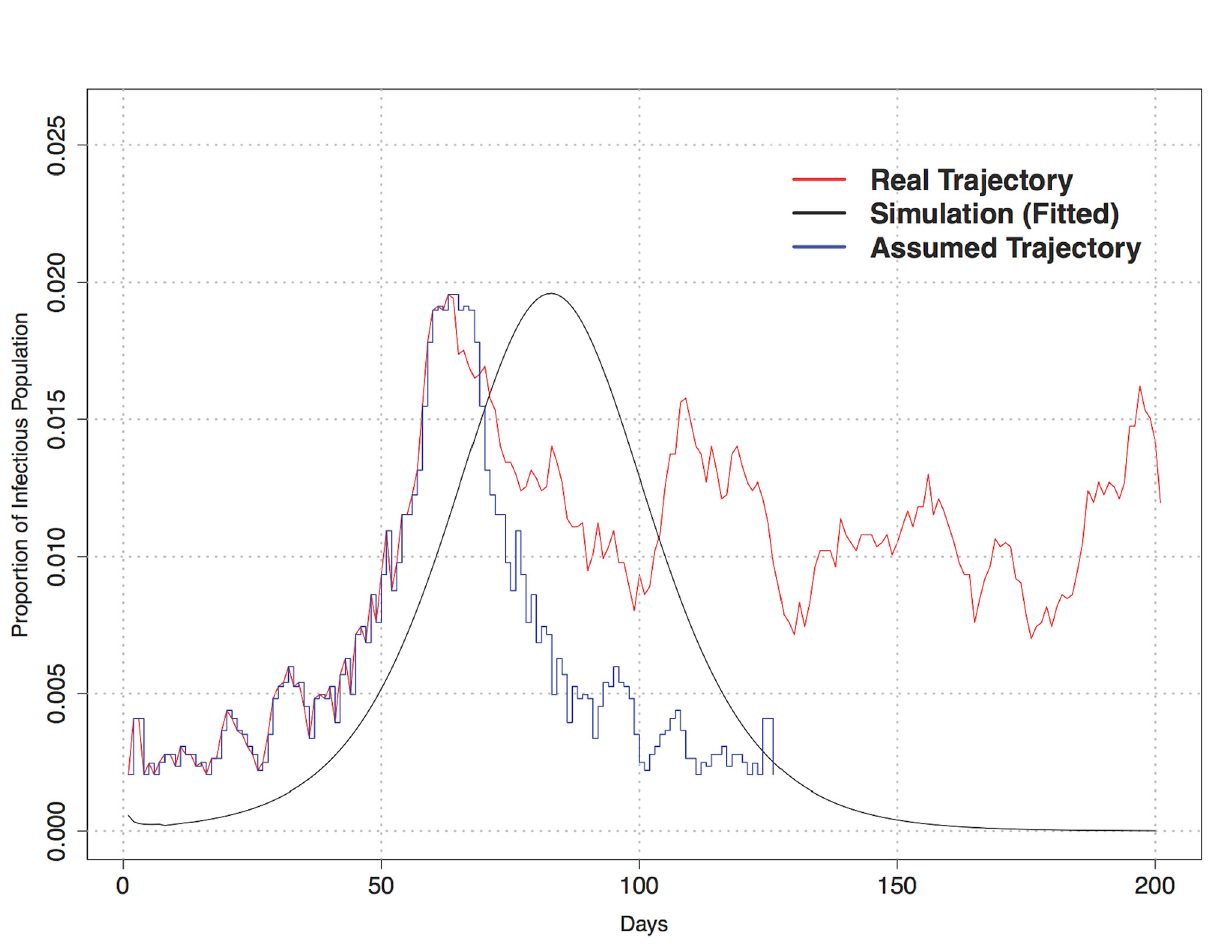
Fig 4. Trajectory of proportion of infectious — Simulation vs.